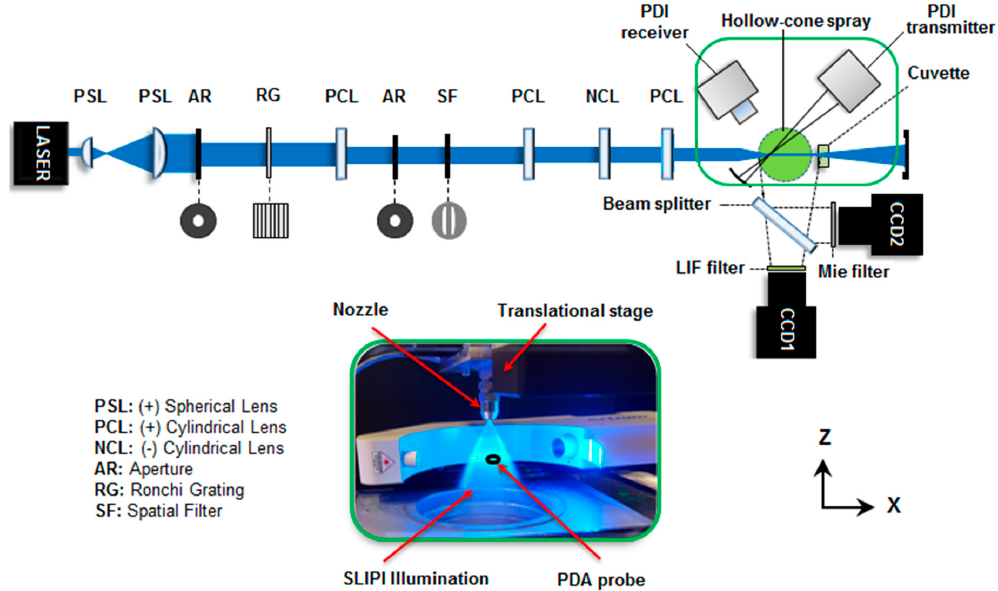
Figure 2. Optical setup of the combined SLIPI laser-induced fluorescence / Mie scattering (SLIPI-LIF / Mie) ratio and SLIPI-scan method. The illumination section (in the green box) consists of a translation stage, spray nozzle, SLIPI illumination, and phase Doppler anemometry (PDA) probe volume. The optical signal detection section consists of a beam splitter, LIF and Mie optical filters, and two identical EM-CCD cameras.